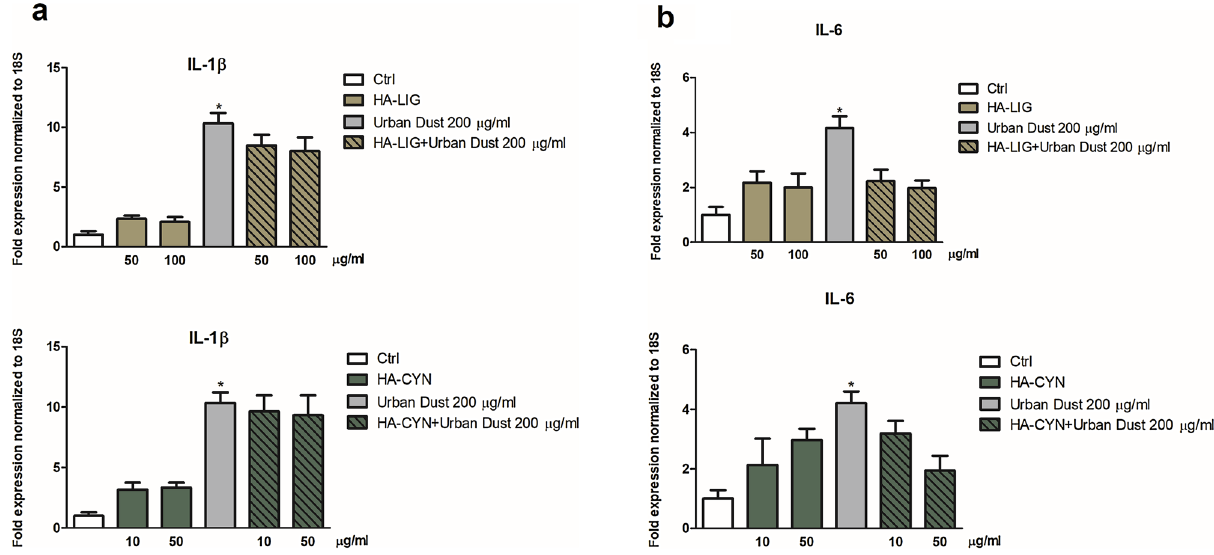
Figure 5. Cellular IL-1β ( a ) and IL-6 ( b ) levels were measured in pellets from HaCaT cells pre-treated for 2 h with either HA-LIG or HA-CYN, and then added with 200 µg mL −1 of Urban Dust, versus a first control of untreated cells (Ctrl), and a second control of cells treated only with 200 µg mL −1 of Urban Dust. Statistical significance of Urban Dust-treated cells was determined in respect to the 100% of IL-1β and IL-6 rate in untreated control cells (*). Data were expressed as mean ± SD of three independent experiments, each performed in triplicate. Student’s t-test was used to calculate significant differences (*P <